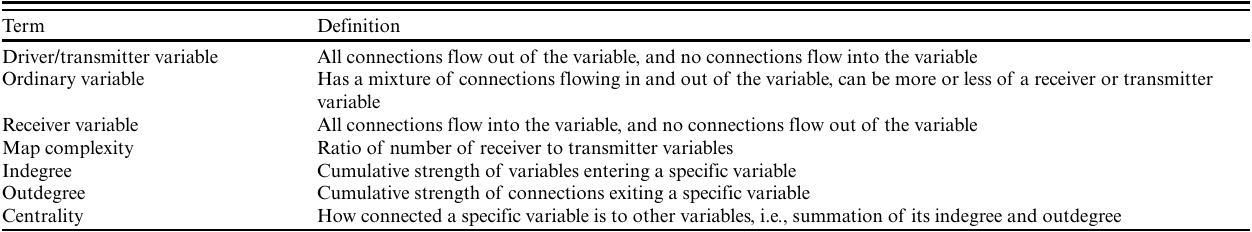
Table 2 . Definitions of terms used relating to fuzzy cognitive mapping.